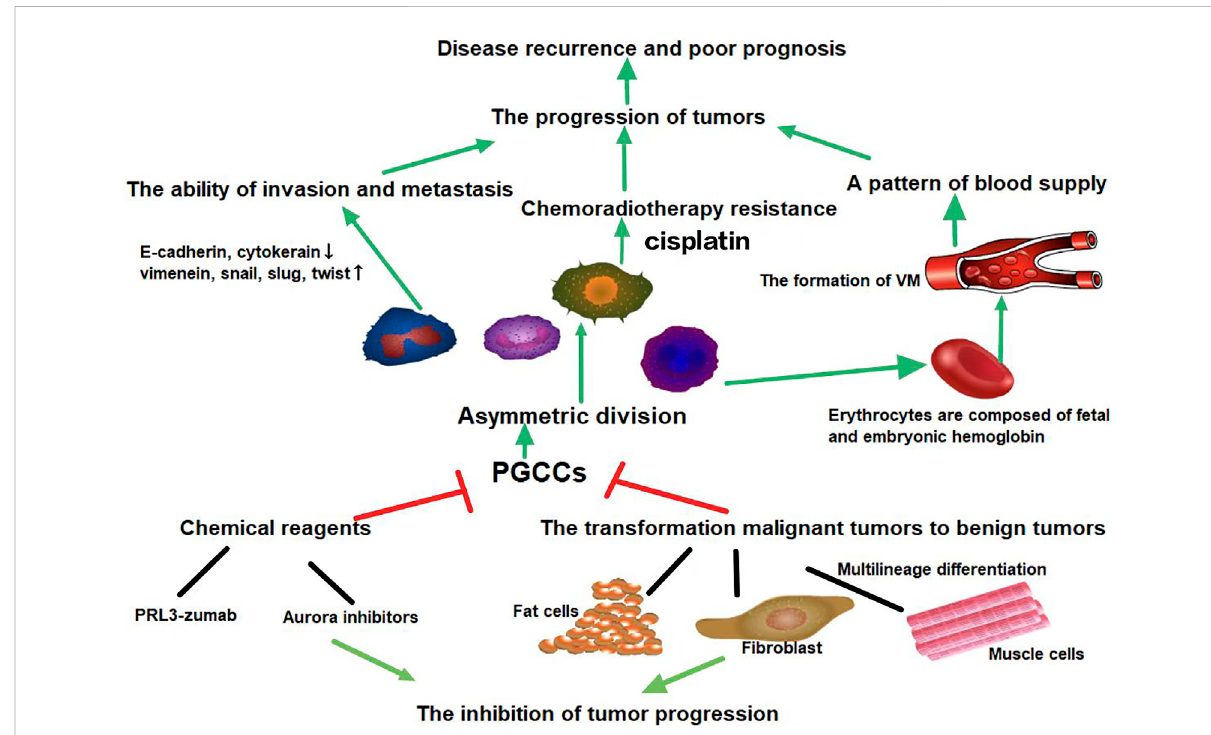
FIGURE 3 PGCCs can generate PDCs via asymmetric cell division. Daughter cells that originate from PGCCs can acquire strong abilities of invasion, metastasis, and chemoradiotherapy resistance. PGCCs can generate erythrocytes to form vasculogenic mimicry. The high oxygen af fi nity of fetal hemoglobin and embryonic hemoglobin derivedfrom PGCCsallowstumorcells to survive inseverehypoxicconditions. Targeting relevant proteins or signaling pathways involved in the formation and transdifferentiation of adipose and cartilage of PGCCs may provide opportunities for solid tumor therapy. Green arrows represent potentiation, while red lines represent inhibitive